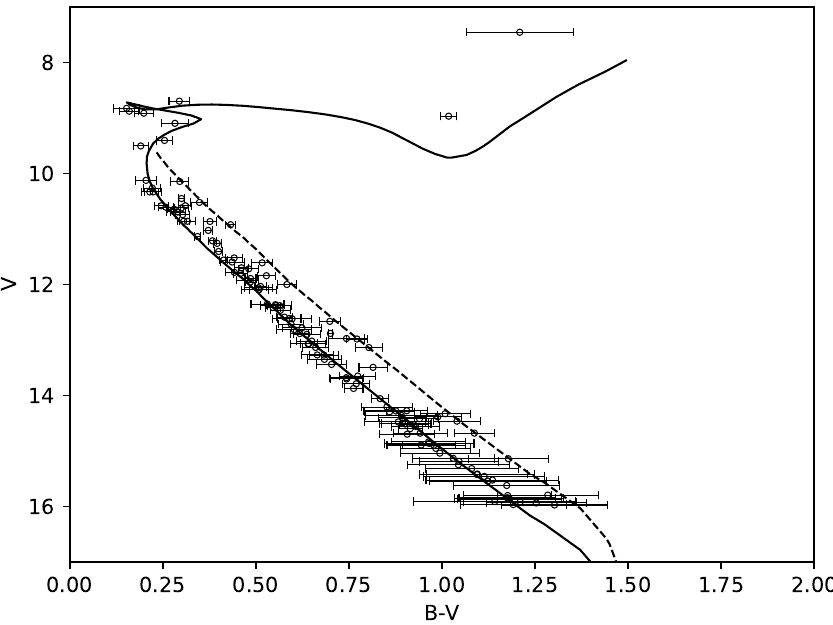
Figure 6. Best isochrone fit for the W MS = 3 and W TO = 5 weights case. The dashed curve represents the bright edge of the binary main sequence, i.e., the single star main sequence brightened by 0.75